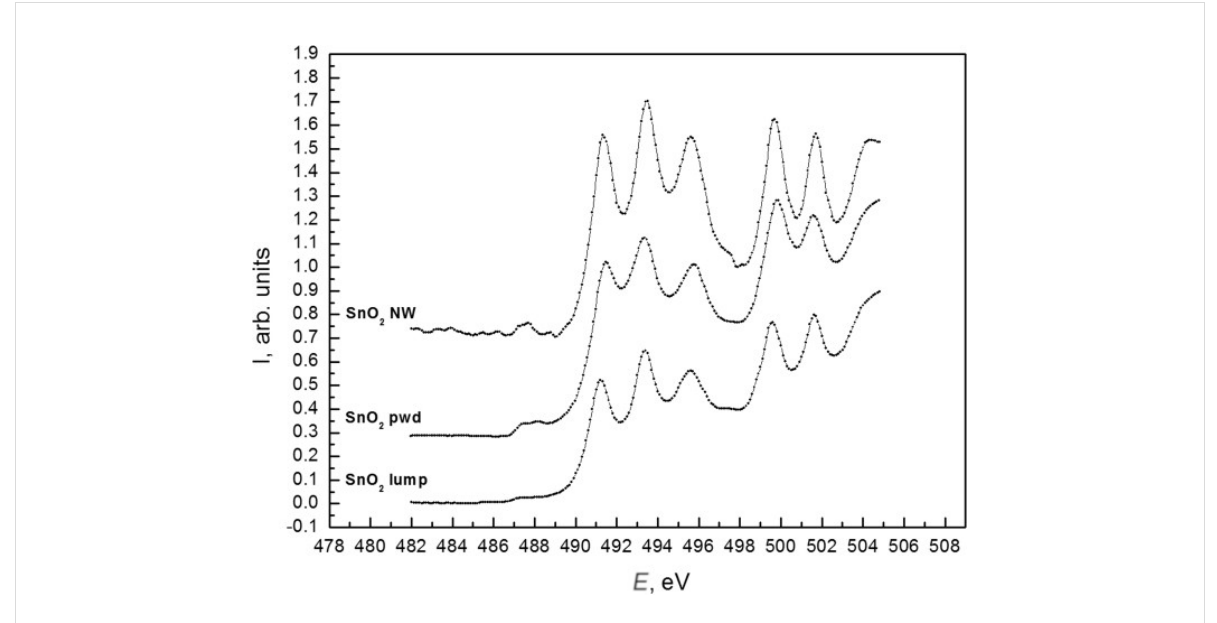
Figure 7: XANES Sn M 4,5 spectra of SnO 2 wire-like crystals (top) [37,38], SnO 2 powder (middle) and sintered SnO 2 lump reference samples (bottom).